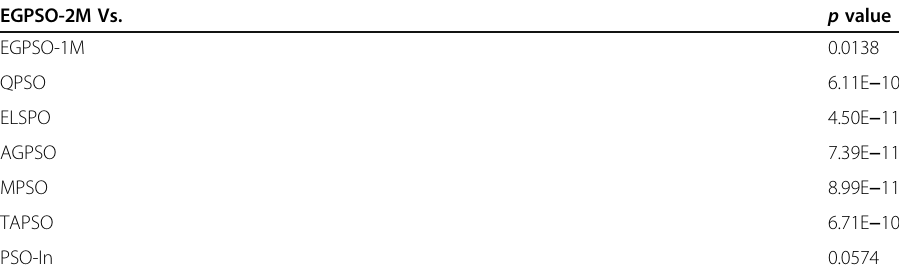
Table 6 p -values of Wilcoxon rank sum test comparison between the results of EQPSO-2M and other algorithms EGPSO-2M